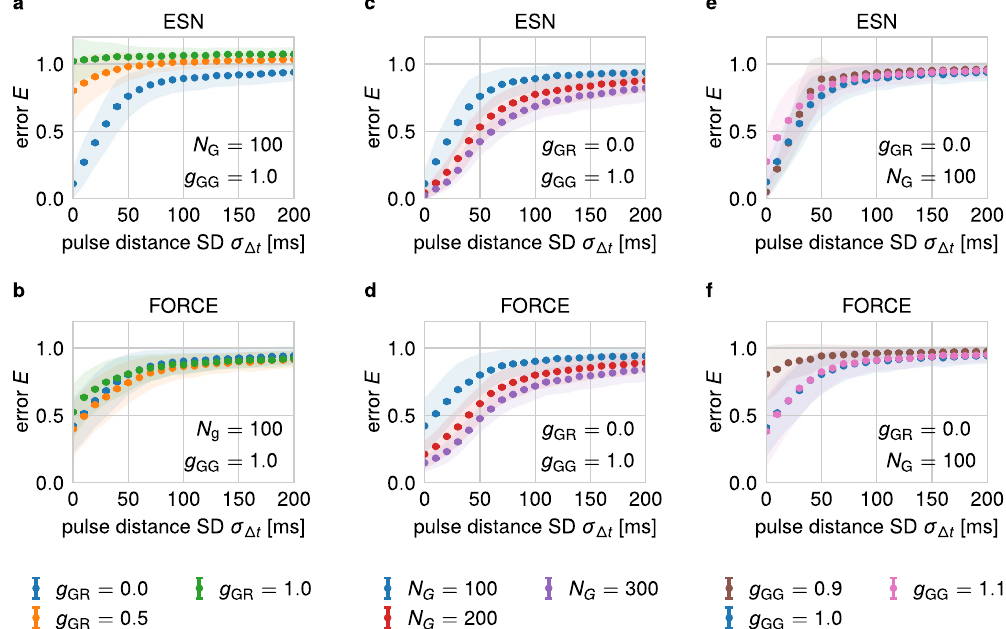
Figure 2. Influence of variances in input timings on the performance of the transient network. The mean normalized readout error E (see Methods) for the benchmark task depicted in Fig. 1 increases with larger standard deviation σ Δ t of the interstimulus intervals of the input stream independent of the used parameters. In ( a , c , e ), the network is trained using the echo state network approach (ESN). In ( b , d , f ), the FORCE-learning method is employed. Every data point represents the mean of 1000 network instantiations. The shaded area indicates the standard deviation of the respective error distribution. The error bars show the standard error of the mean. If for one instantiation the error after training is larger than 1.5, we consider the respective training procedure as not converged and exclude it from the mean. ( a , b ) The network is trained with three different values of the standard deviation g GR of the feedback-weights from the readout neurons to the generator network. For both training methods, increasing g GR also increases the error E for a given value of σ Δ t . The constant parameters are N G = 100 and g gg = 1.0. ( c , d ) Networks of different sizes, i.e. different values of N G , are trained to perform the benchmark task. While larger networks perform better for a given value σ Δ t , they qualitatively show the same strong sensitivity to variances in input timings. The constant parameters are g GR = 0 and g gg = 1.0. ( e , f ) The influence of different values g GG of the internal weights of the generator network is investigated. Neither increasing nor decreasing of the critical value g GG reduces the error significantly. The constant parameters are g GR = 0 and N G =